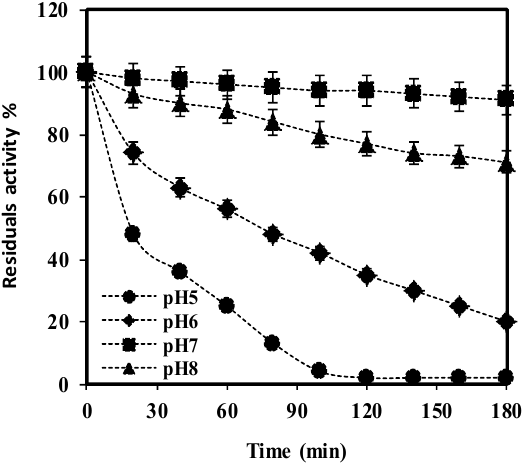
Figure 8. The pH stability of purified S. griseus recombinant β -glucosidase was determined by incubating enzyme solutions containing 7 mM pNPG in buffers of various pH, ranging between 5 ( ), 6 ( ), 7 ( ), and 8 ( ), over a period of 180 min at 37 °C. Residual activity (%) at each time point was calculated considering the initial activity, at zero time as 100%. Data represent the mean of three independent experiments, with standard deviations noted as error bars.